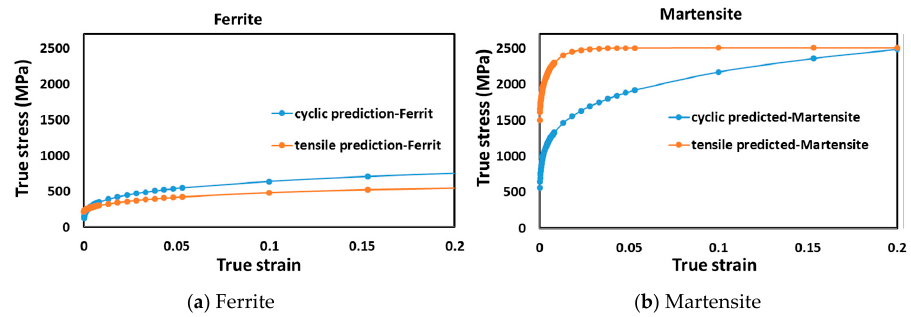
Figure 5. Monotonic flow curve and predicted cyclic curve of single phases (ferrite, martensite).